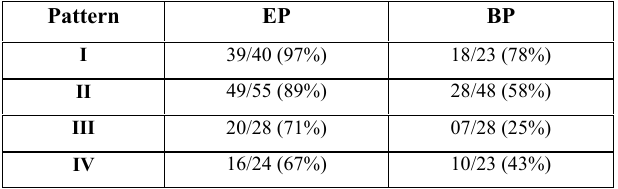
Table I – Null (vs overt) subjects in transcribed interviews, according to the structural context (Adapted from Barbosa, Duarte and Kato, 2005: 24)